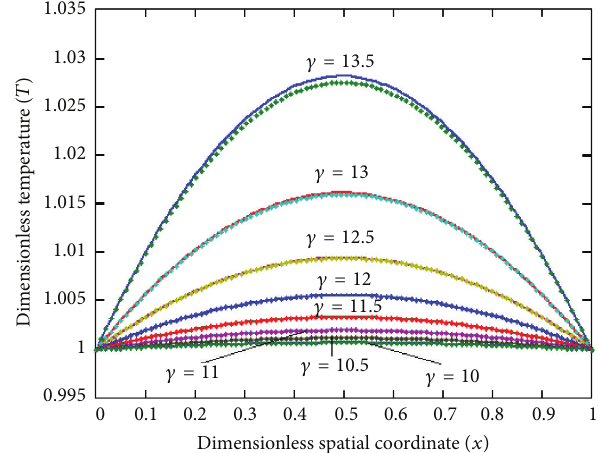
Figure 2: Dimensionless temperature T versus dimensionless spa- tial coordinate using (6) for Le = 0.233, 𝛽 = 4.287, 𝛾 =13.6, and various values of 𝜙 2 . Solid lines represent the analytical solution, whereas the dotted lines are for the numerical solution.